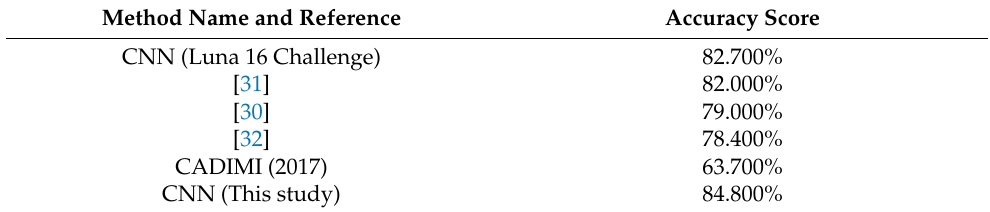
Table 3. Comparison of results.